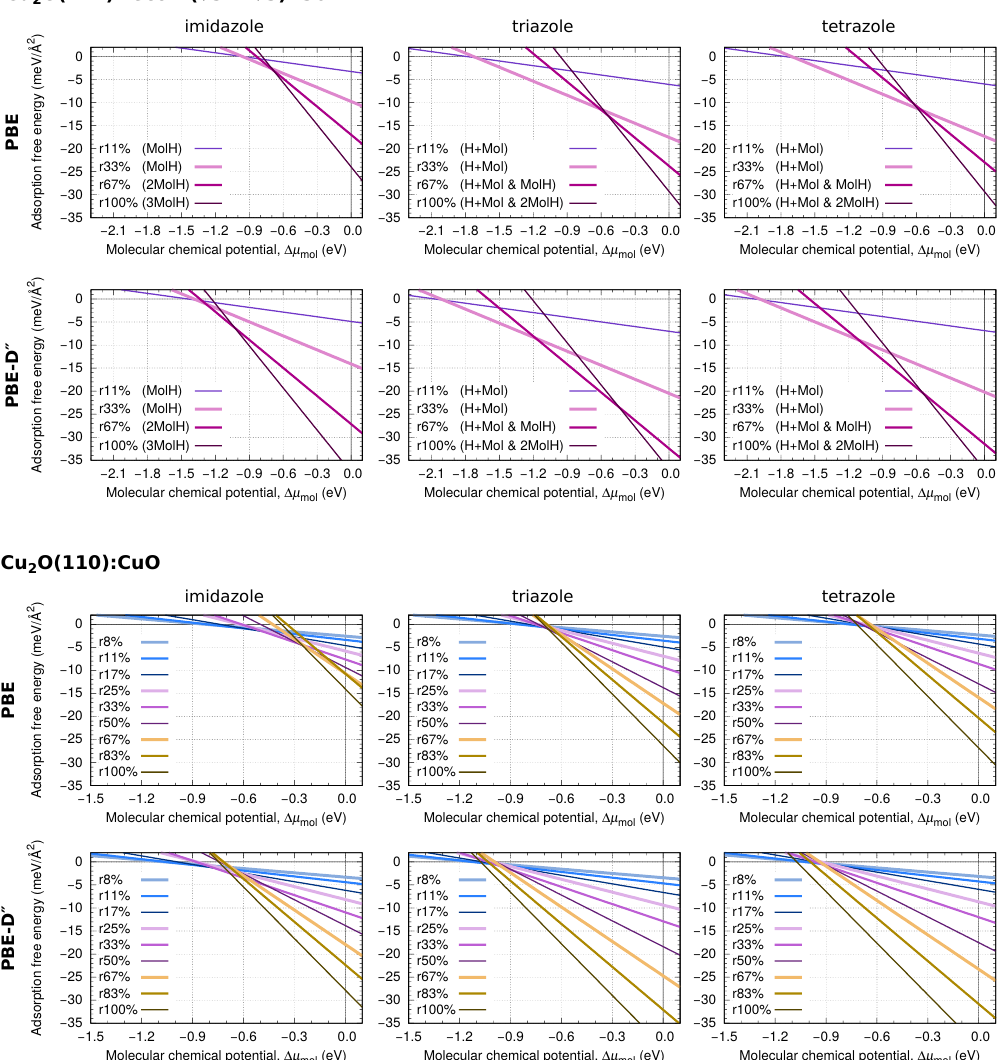
Figure A5. As in Figure A4, but for Cu 2 O(111)-recon-( Only the preferred adsorption modes at given coverages are considered. In particular, triazole and tetrazole prefer to adsorb dissociatively on Cu 2 O(111)-recon-( “H+Mol”) and above it in mixed-mode (marked as “H+Mol & n MolH”, n = 1 or 2). For all other cases the molecules prefer to adsorb